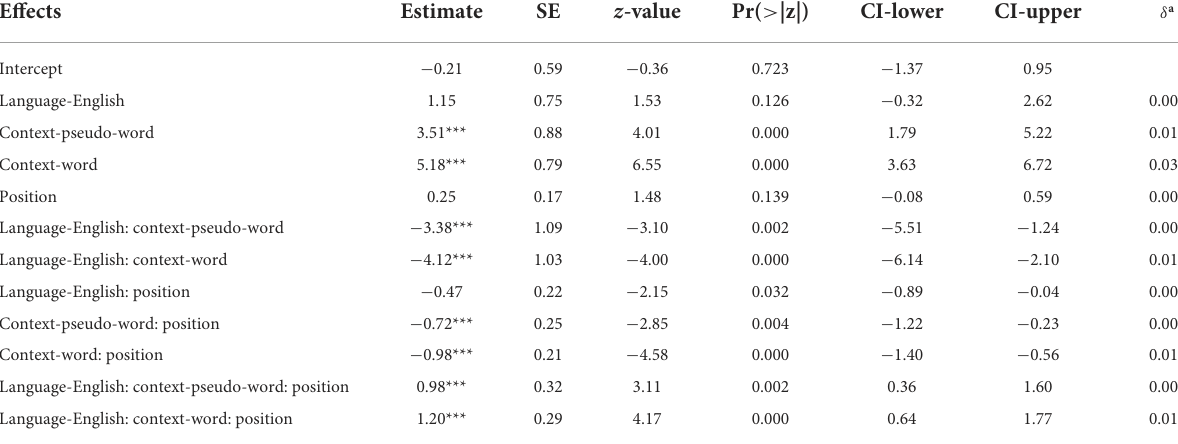
TABLE 2 Summary of the optimal GLME model and its parameter estimates.